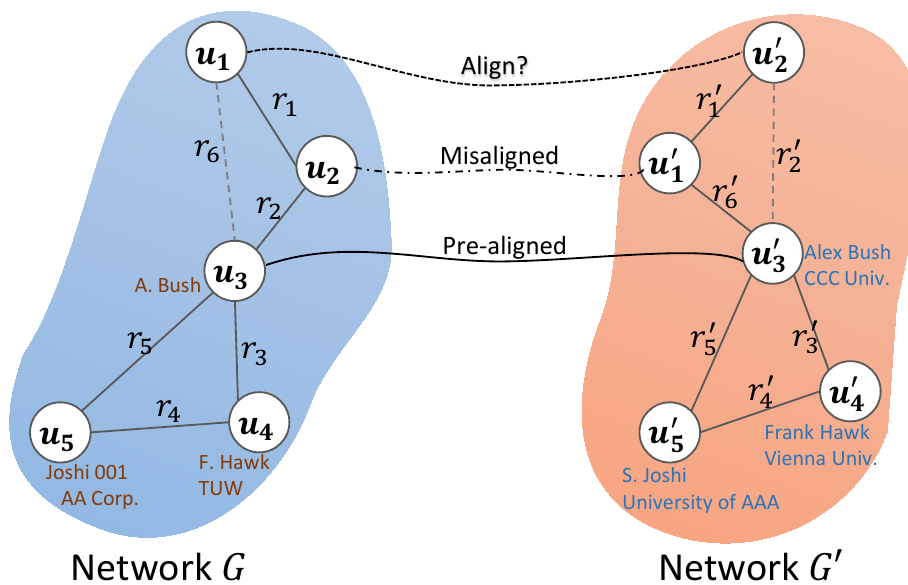
Figure 1. An example of user alignment across social networks. G and G (cid:48) denote two networks to be aligned. The lines between users within each network represent the relations between users, where solid lines ( r 1 and r (cid:48) , etc.) and dashed lines ( r 6 and r (cid:48) ) represent actual existing user relations and 2 1 potential but not observed relations, respectively. The lines between two users across G and G (cid:48) denote the UA problem. The solutions determine whether potential user relations actually exist or